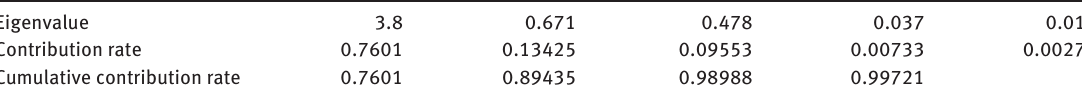
Table 2. Eigenvalues and Eigenvectors of the Correlation Coefficient Matrix.